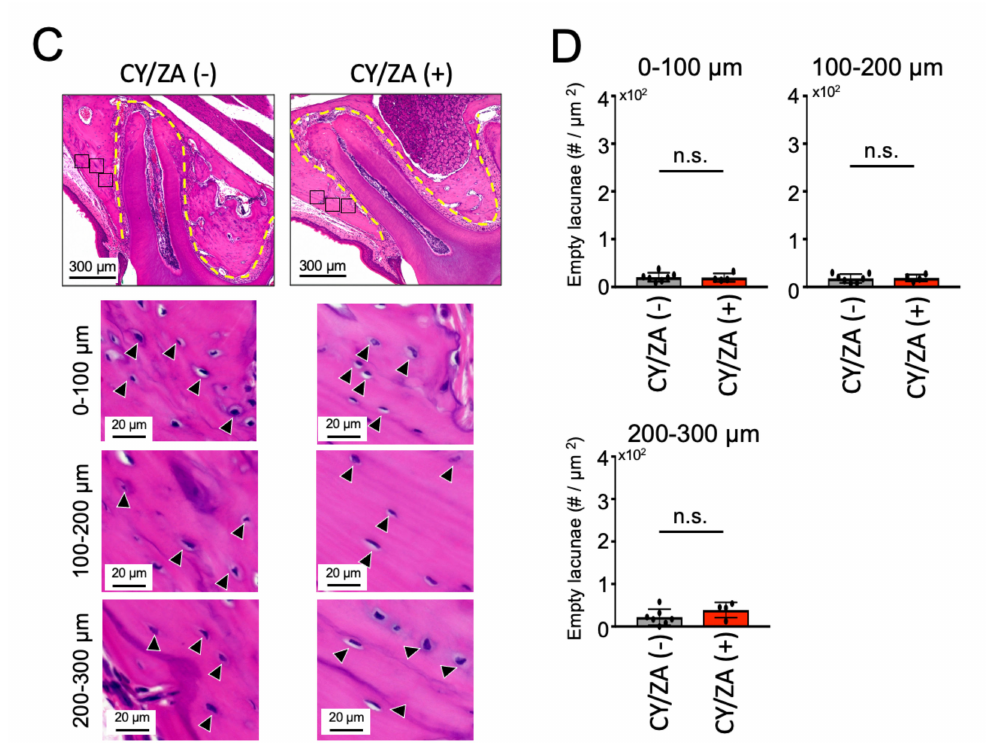
Figure 1. Effect of CY/ZA administration on the alveolar bone around the tooth root. ( A ) Experimen- tal design; Administration of CY/ZA for three weeks before tooth extraction of the maxillary first molar. CY: cyclophosphamide, ZA: zoledronate. ( B ) Graphic image of the selected bone areas around the tooth root socket. Green, Red and purple lines represent the areas at 0 µ m to 100 µ m, 100 µ m to 200 µ m and 200 µ m to 300 µ m from the surface of the tooth socket, respectively. ( C ) Hematoxylin and Eosin (HE)-stained sagittal images of the bone surrounding the tooth sockets after CY/ZA administration. The control group was injected with saline. The yellow line indicates the tooth root socket. Black and white arrowheads represent lacunae with and without cells, respectively. ( D ) The graph shows the quantitative analysis of empty lacunae in the bone surrounding the tooth root socket. Bars represent the mean ± standard deviation. ns: no significant difference. unpaired Students’ t -test, n =